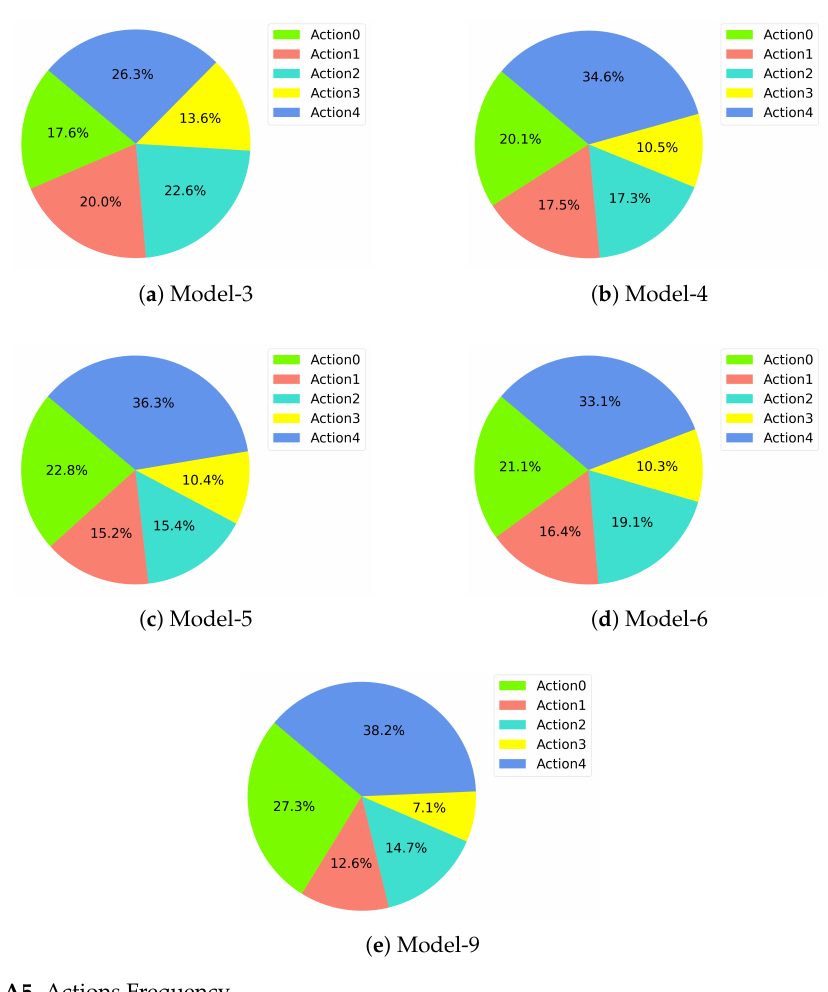
Figure A5. Actions